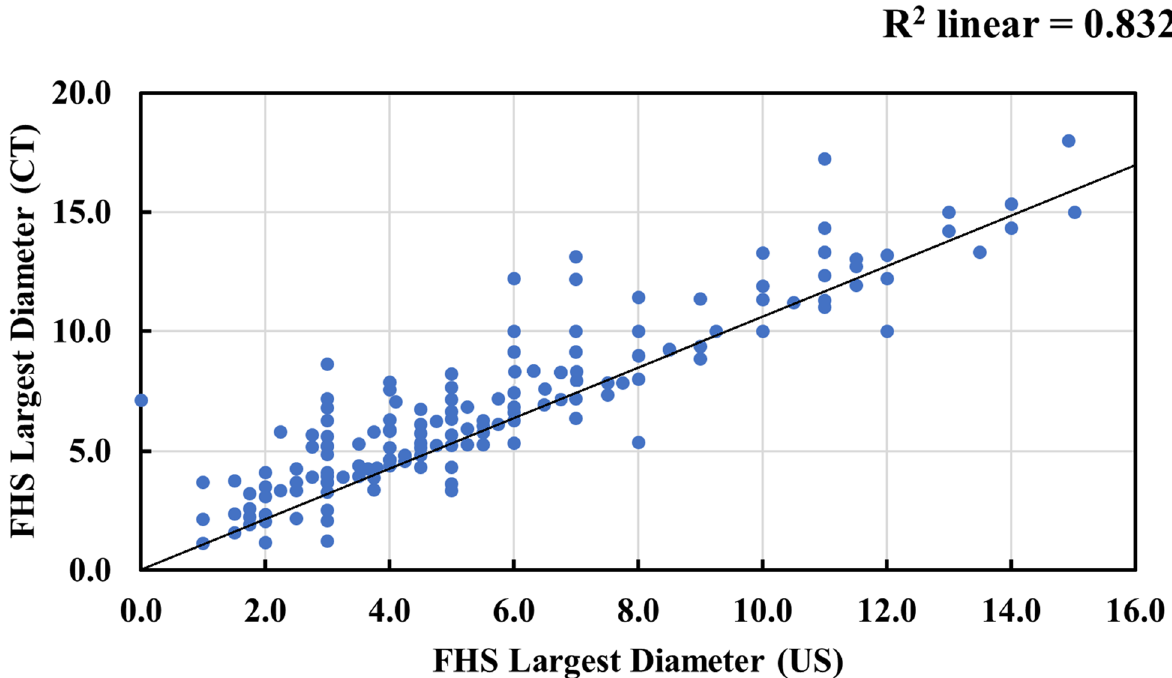
Fig. 7 Correlation between size of hepatic focal lesions by US and CT Fig. 7 There was statistically significant positive correlation between the largest tumor diameter by US and by CT scan (rs 0.896, P < =